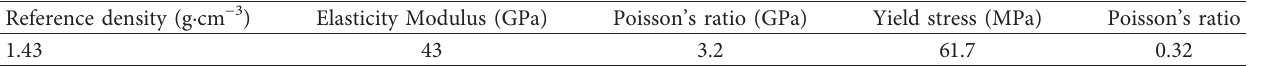
Table 2: Mechanical parameters of shaped pipe.